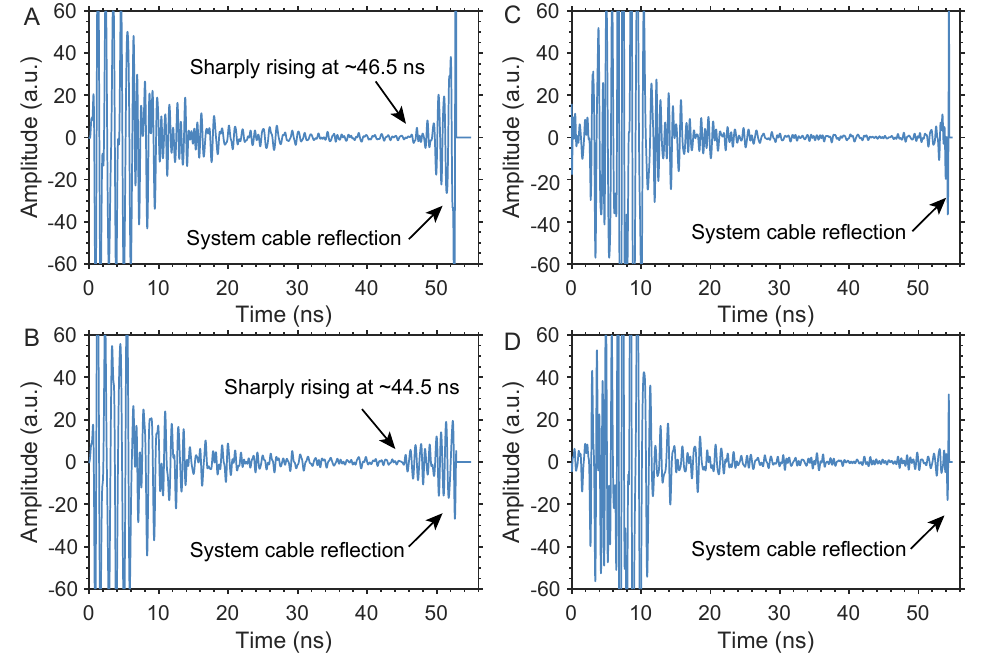
Figure 4. Comparative analysis of the lunar observation data ( A , B ) and ground verification data ( C , D ) obtained by the LRPR and LRPR prototype. In the ground verification experiment, the lunar regolith simulant observed by the LRPR is made of terrestrial volcanic ash. Here, the radar signals are received by the closest spacing between the transmitting antenna and the receiving